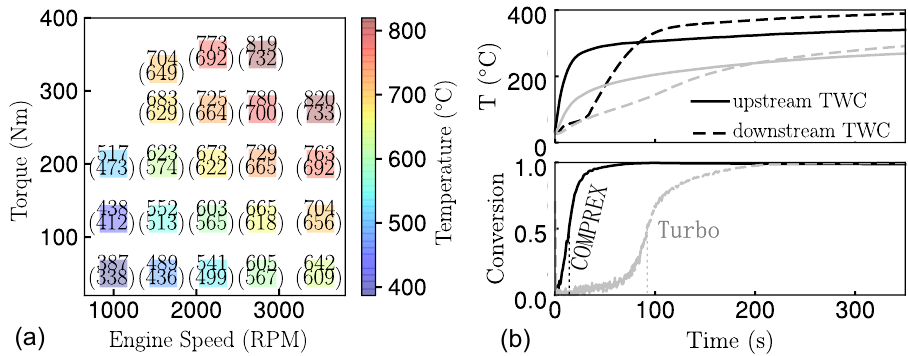
Figure 16. ( a ) Steady-state temperature upstream the TWC for the Comprex and the turbocharger in brackets. At low engine loads, the centre of combustion was set to 8 ◦ CA after top dead centre in all cases. ( b ) Temperature (top) and CO conversion rate (bottom) evolution during cold start at 1000 rpm and 50 Nm, centre of combustion 8 ◦ CA after top dead centre start for the Comprex setup (black) and the turbocharger setup (grey). A Comprex speed of 4000 rpm was used for this cold-start measurement.